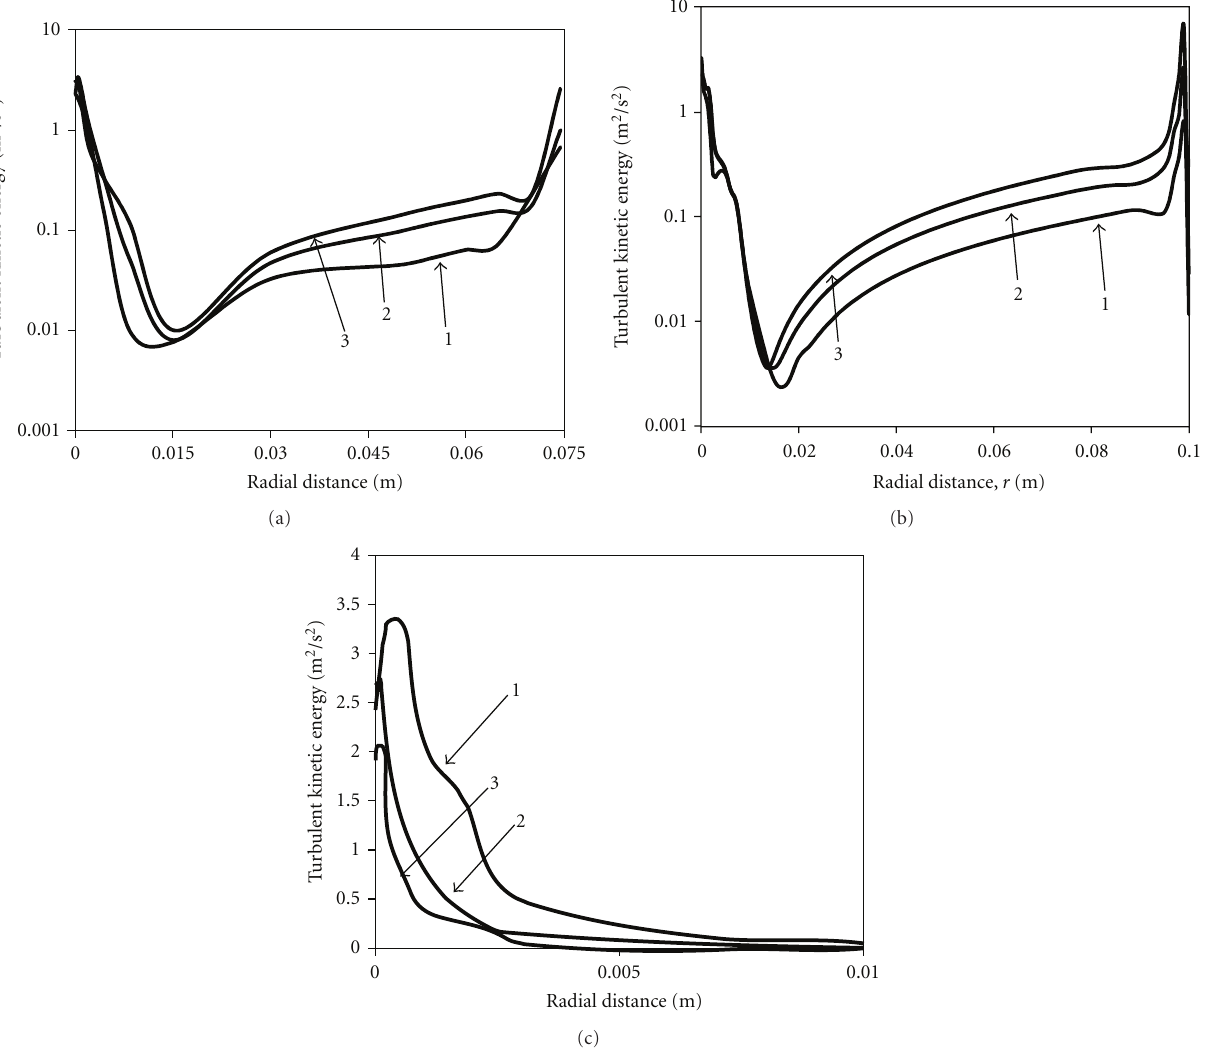
Figure 3: Variation of turbulent kinetic energy ( k ) along radial coordinate [ z = 0 . 00075 m]. (a) Disc diameter: 0.15 m, flow rate: 300mL/min, line 1: 600 rpm, line 2: 1000 rpm, line 3: 1400 rpm. (b) Disc diameter: 0.20 m, flow rate: 300 mL/min, line 1: 600 rpm, line 2: 1000 rpm, line 3: 1400 rpm. (c) Disc diameter: 0.15 m, rotation speed: 1000 rpm, line 1: 300 mL/min, line 2: 190 mL/min, line 3: 110